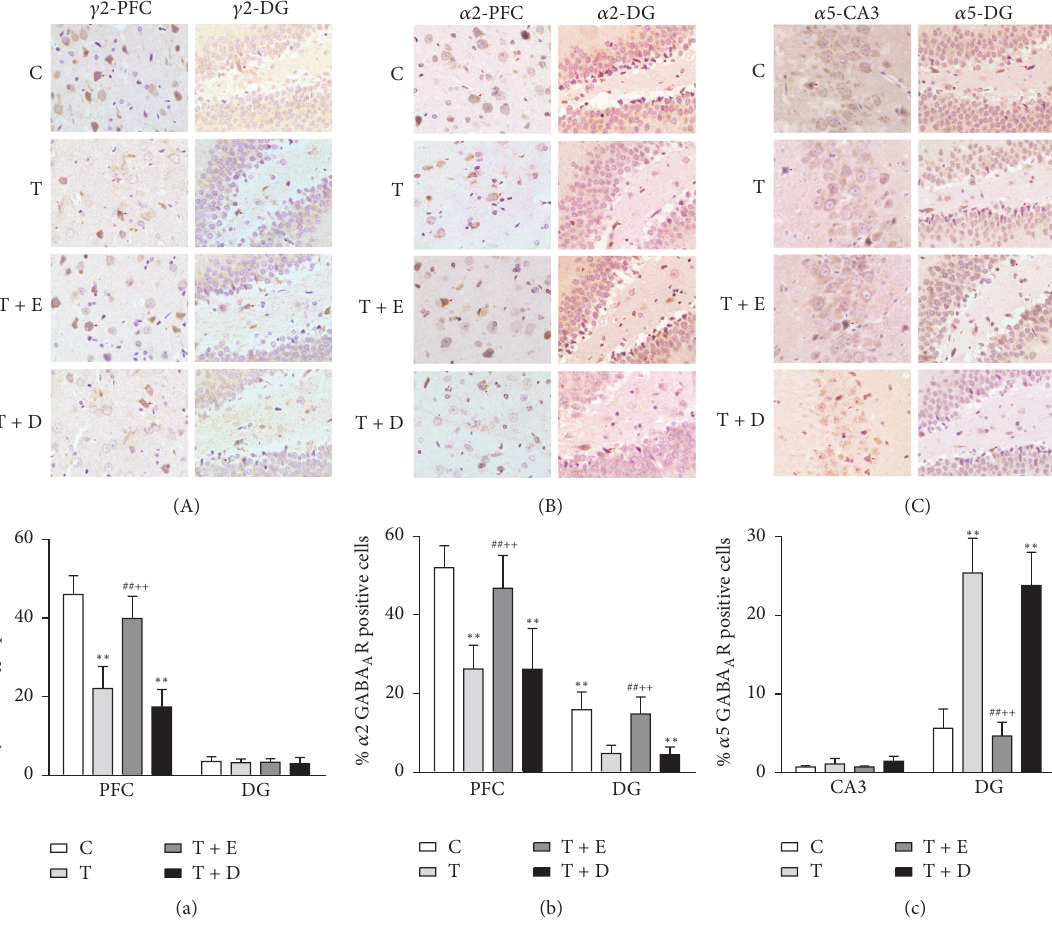
Figure 3: Representative expression of the GABA R subunits in the PFC, CA3, and dentate gyrus (DG) of the hippocampus ( × 400). The A neurons with positive 𝛾 2 subunit expression and the results of positive cell counting in the PFC and DG were shown in (A) and (a). The neurons with positive 𝛼 2 subunit expression and the results of positive cell counting in the PFC and DG were shown in (B) and (b). The neurons with positive 𝛼 5 subunit expression and the results of positive cell counting in the DG and CA3 subregions of the hippocampus were shown in (C) and (c). Values were expressed as mean ± SEM ( 𝑛 = 6 , per group). ∗∗ 𝑝 < 0.01 versus C group; ## 𝑝 < 0.01 versus T group; ++ 𝑝 < 0.01 versus T + D